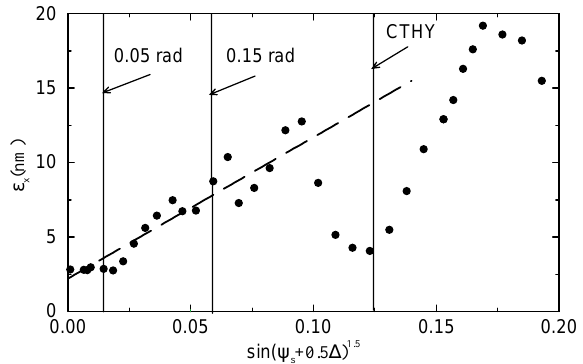
FIG. 4. A comparison between data points based on the chip model with s D (cid:1) 0.1 m m and the sin 3 (cid:3) 2 c law as indicated by the dashed line.